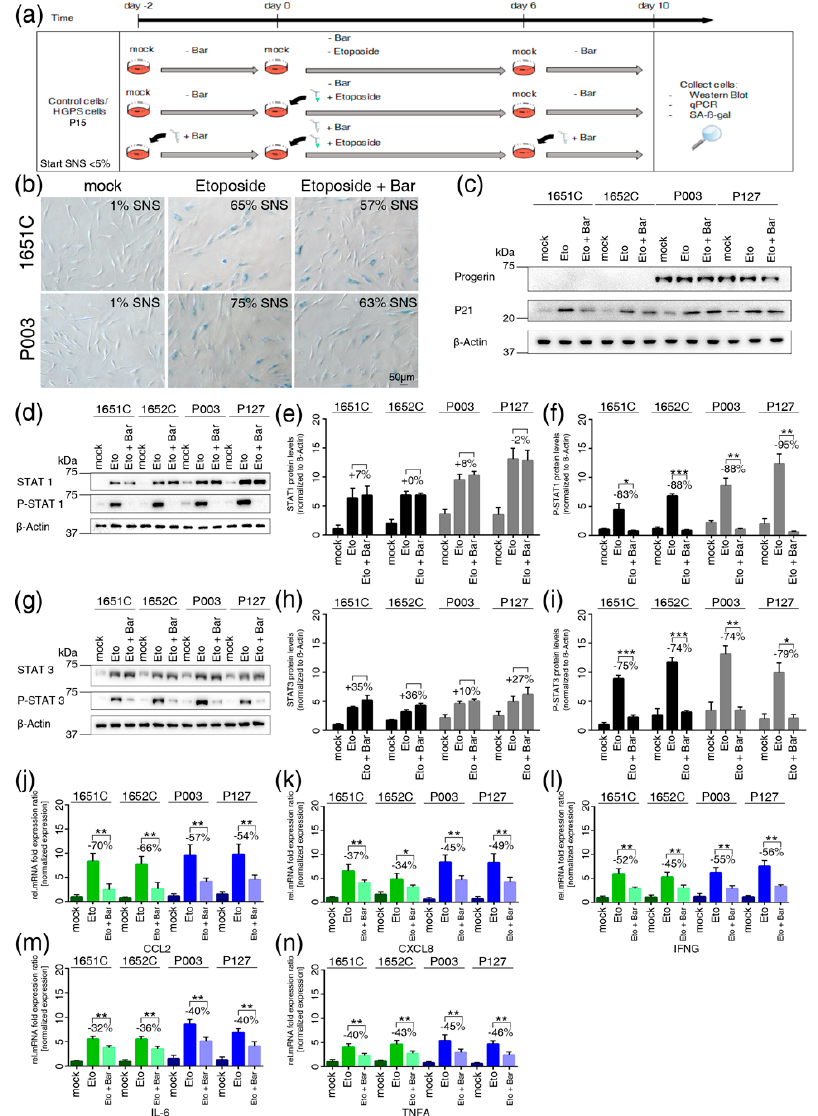
Figure 6. Etoposide treatment activates the JAK-STAT signaling pathway in HGPS and normal cells. ( a ) Schematic representation of the etoposide treatment protocol. All treatments started with cultures exhibiting < 5% senescence (SNS). Cells were either pretreated with or without 1 µ M Bar for two days and then expose to medium with or without etoposide in the presence or absence of Bar for a period of six days. Next, cells were grown for four days with or without Bar as indicated. ( b ) Representative images of SA-ß-gal-positive cells in mock-, etoposide- and etoposide + Bar-treated cultures (GMO1651c and HGADFN003) are shown. The percentages of senescence (SNS) after treatment are indicated. ( c ) Representative images of western blots for progerin, p21 and ß-actin in normal (GMO1651c, and GMO1652c) and HGPS (HGADFN003, and HGADFN127) cells treated as indicated. ( d ) and ( g ) Representative images of western blots for JAK1 / 2, STAT1 / 3, P-STAT1 / 3 and ß-actin in normal (GMO1651c, and GMO1652c) and HGPS (HGADFN003, and HGADFN127) cells treated as indicated. ( e ) Quantification of STAT1, ( f ) p-STAT1, ( h ) STAT3, and ( i ) p-STAT3. The percent change between etoposide- and etoposide + Bar-treated cells is indicated. ( j – n ) Quantitative real-time PCR analysis of CCL2, CXCL8, IFNG, IL6, and TNF α in cells treated as indicated. Relative expression was normalized to the expression of GAPDH. Graphs show the mean ± SD. Comparisons were done by two-tailed t test (* p < 0.05, ** p < 0.01, *** p < 0.001). All experiments were repeated at least three times ( n >